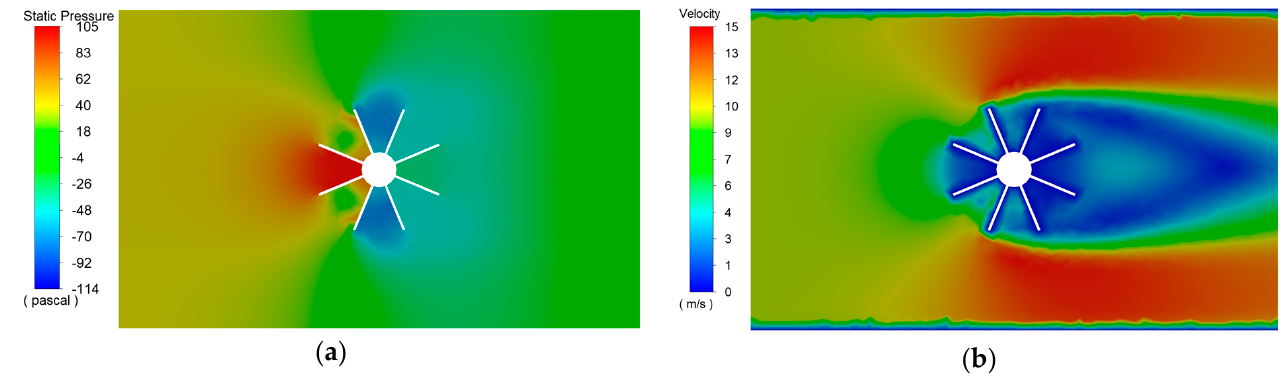
Figure 13. ( a ) Pressure distribution; ( b ) Velocity distribution for the tube with 8 fins (case c5).